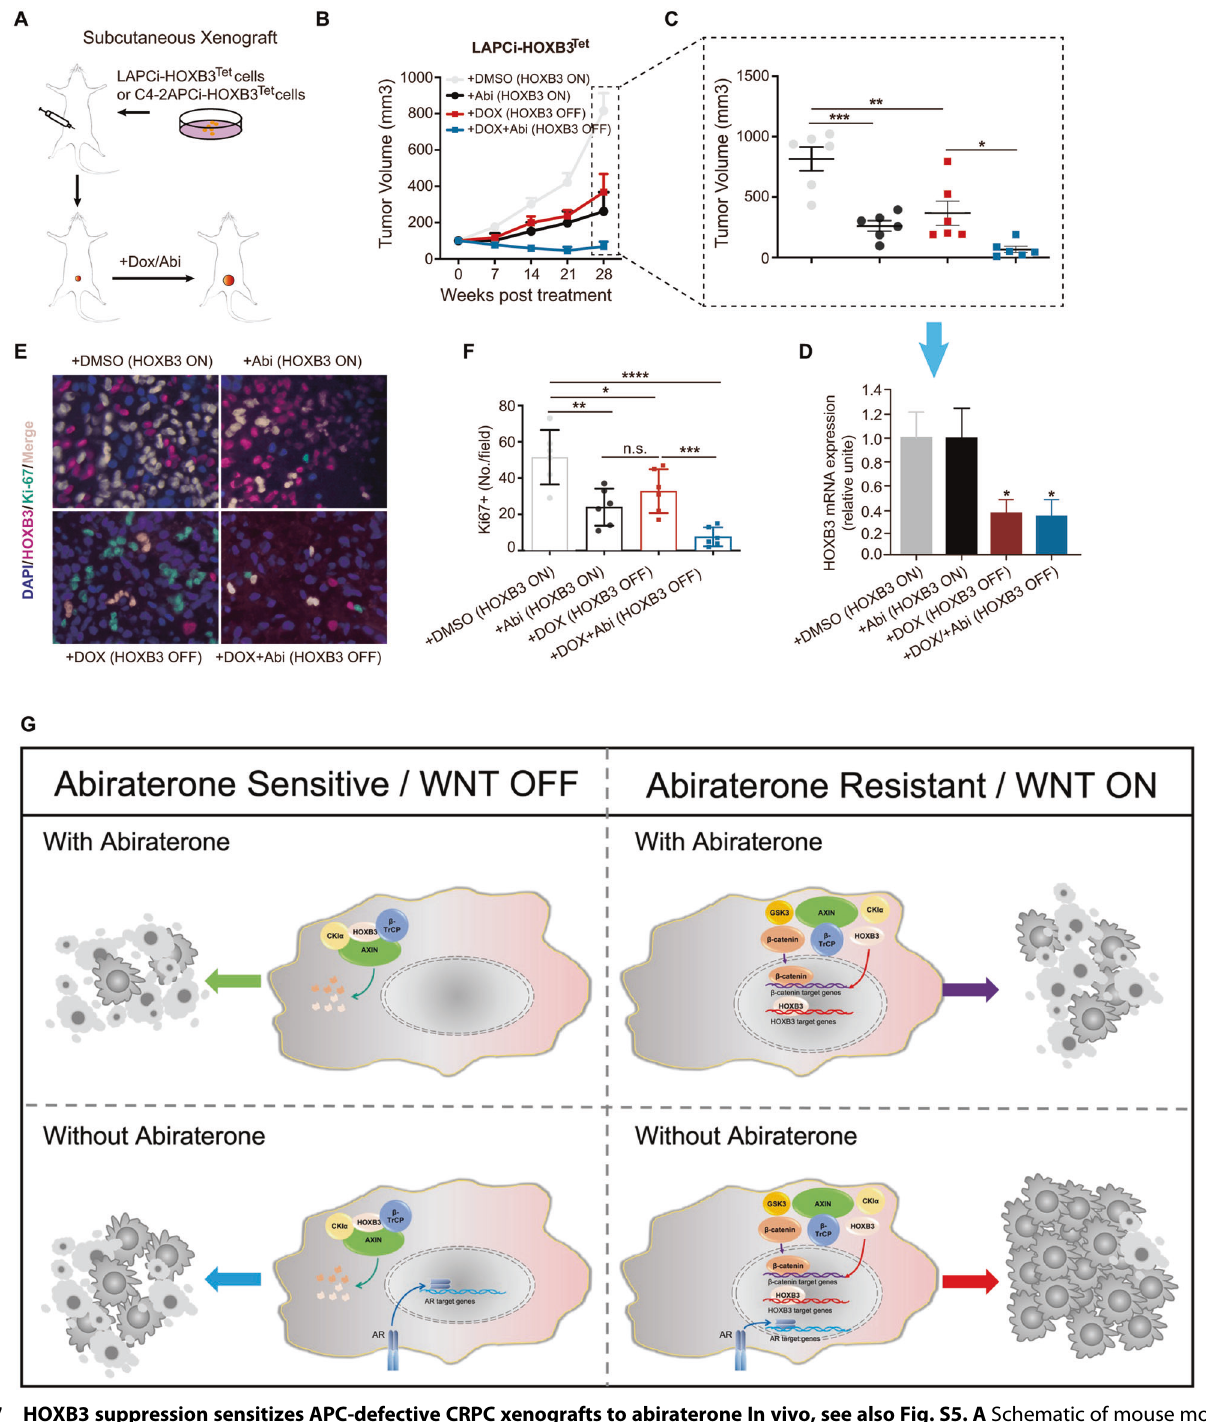
Fig. 7 HOXB3 suppression sensitizes APC-defective CRPC xenografts to abiraterone In vivo, see also Fig. S5. A Schematic of mouse models of subcutaneous xenografts generated with LNCAP-AI or C4-2 cells stably infected with shAPC and Tet-on shHOXB3. When the tumors size approached approximately 100 mm 3 , mice were randomized to receive DMSO, 0.5 mg/mL Doxycycline (HOXB3 ON), 200 mg/Kg abiraterone, or both (HOXB3 ON). B , C Caliper measurements were taken weekly for LNCaP-AI xenografts. n = 6 mice per group. B Line graph with bar showing changes of tumor volumes weekly in each group; ( C ) Scatter plots with bar showing individual tumor volumes at 28 days post- randomization in each group. D Bar graph showing HOXB3 stable suppression in HOXB3-OFF LNCaP-AI xenografts at 28 days post- randomization. HOXB3 mRNA levels were measured by qRT-PCR. E Immuno fl uorescent staining of Ki67 (green) and HOXB3 (red) in LNCaP-AI xenografts. Nuclei are stained with DAPI (blue). F Scatter plots with bar showing Ki67 expression in each group. G Graph abstract depicting the roles of HOXB3 as another downstream effector of the WNT signaling pathway in the WNT ON state. Error bars indicate mean ± SD. * p < 0.05, ** p < 0.01, *** p < 0.001.